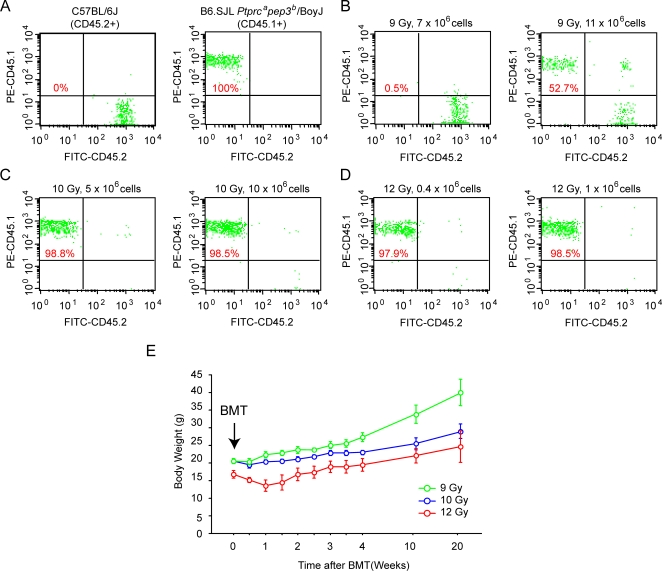
Effects of irradiation dosage on engraftment and body weight.Mice that differ in CD45 cell surface markers were irradiated with 9, 10, and 12 Gy and transplanted with bone marrow (1×106 bone marrow cells) and the rate of chimerism in blood cells were determined by sorting with the specific antibodies for CD45.1 and CD45.2. In an additional control experiment, FACS analysis was performed without BMT using blood cells from C57BL/6J (CD45.2+) and B6.SJL PtprcaPep3b/BoyJ (CD45.1+) mice (A). FACS analysis using blood cells from CD45.1→CD45.2 BMT in mice that were irradiated with 9 Gy (B), 10 Gy (C), or 12 Gy (D). Body weight change in the three groups of mice (irradiated with 9, 10, and 12 Gy) following BMT on a regular diet (E). Percentage of reconstitution was calculated and displayed in each graph.